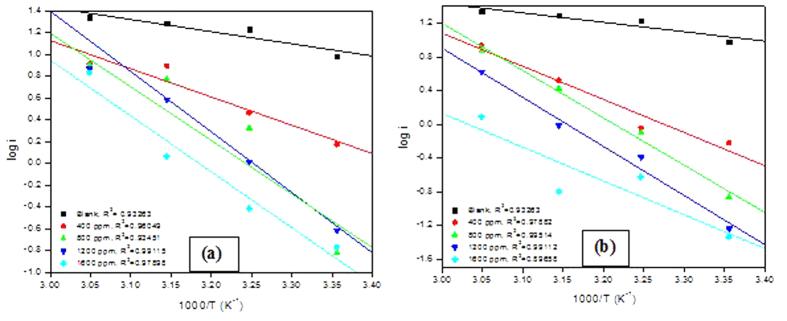
Arrhenius plots for MS in 0.5 M H2SO4 without and with various concentrations of (a) PNVP-PU and (b) PDMAEMA-PU.